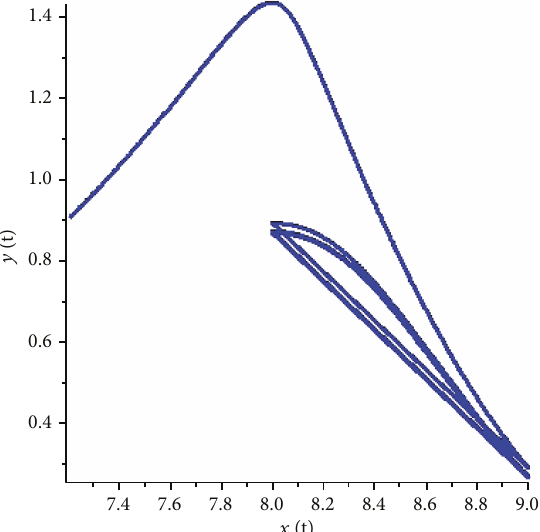
Figure 16: There exists an order-1 periodic solution in system (16) with q 1 = 1/9 , p = 0 8 , and τ = 0 6 .